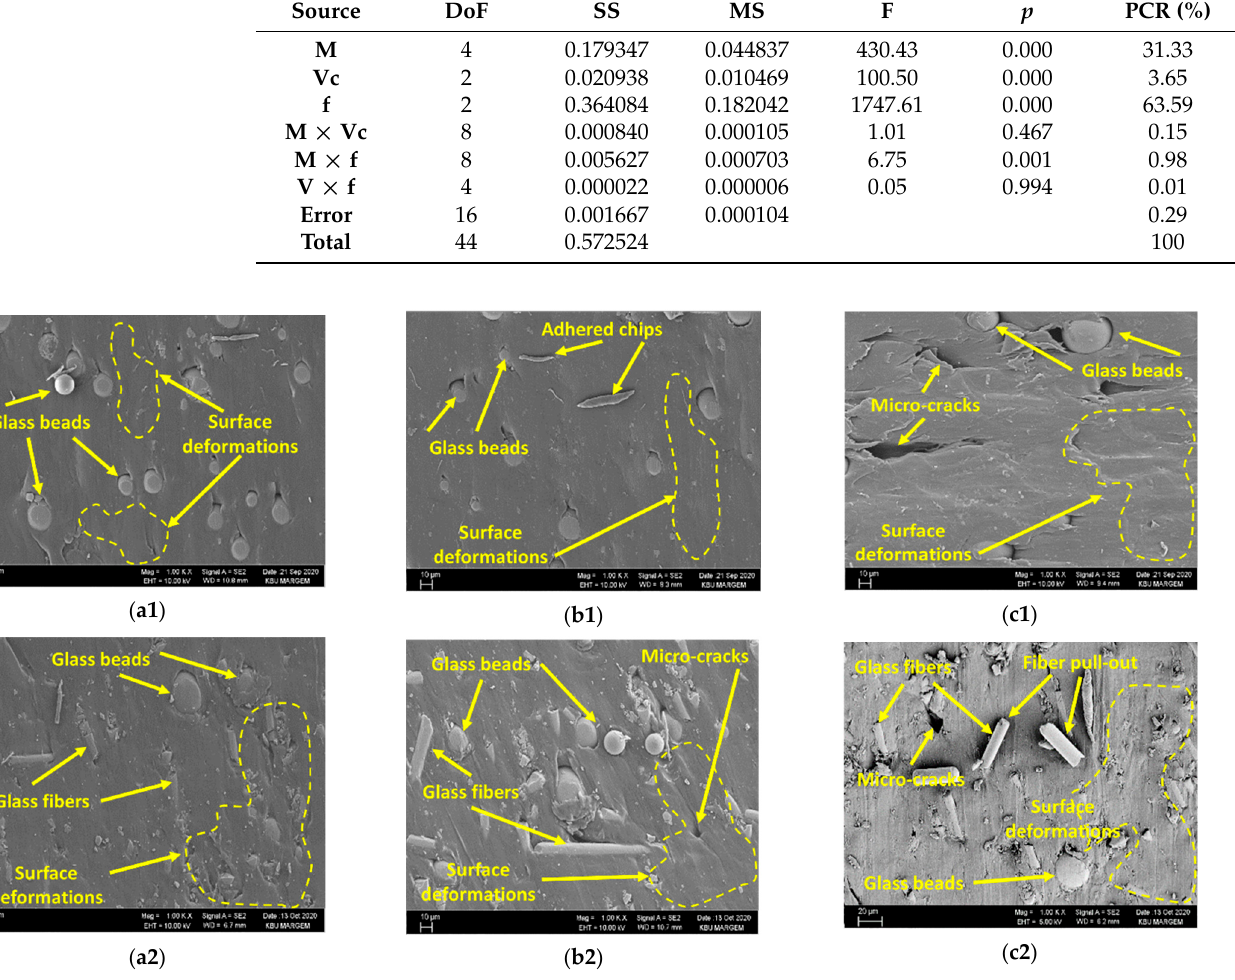
Figure 6. The hole surfaces at V = 45 m/min; ( a1 , b1 , c1 ) C1 and ( a2 , b2 , c2 ) C4 for from 0.05 mm/rev to 0.15 mm/rev, respectively. to 0.15 mm/rev, respectively.